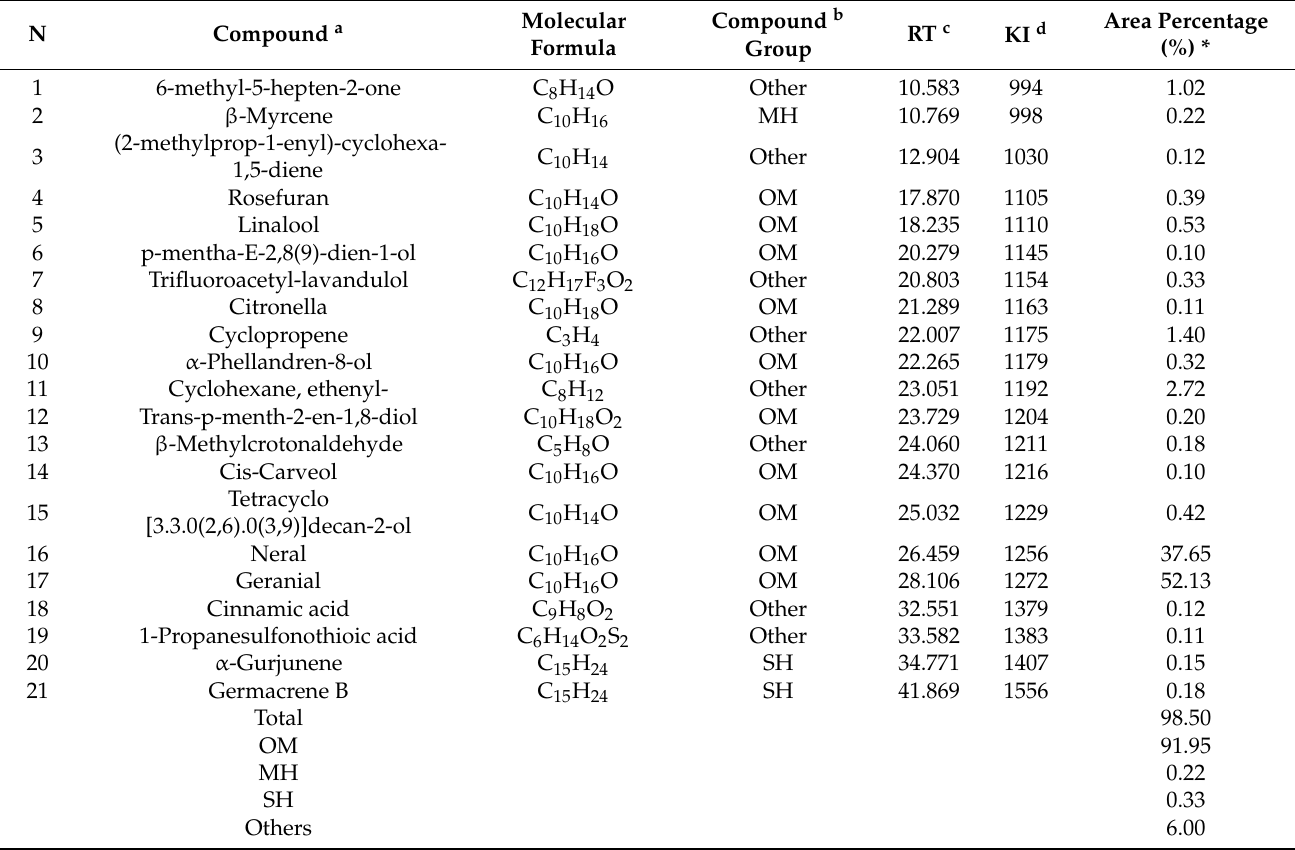
Table 1. Chemical composition of